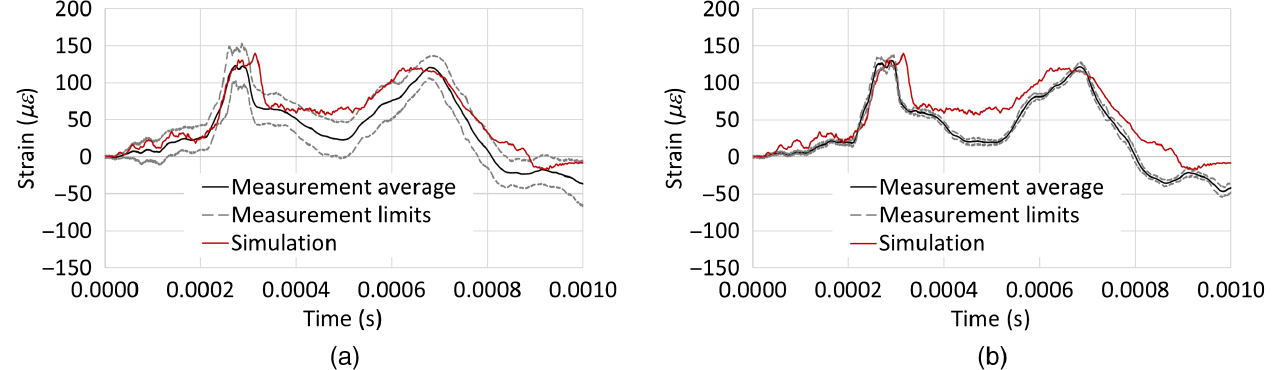
FIG. 30. Average and limits of ten strain responses from sensor T30-A acquired in burst mode (a) and individually